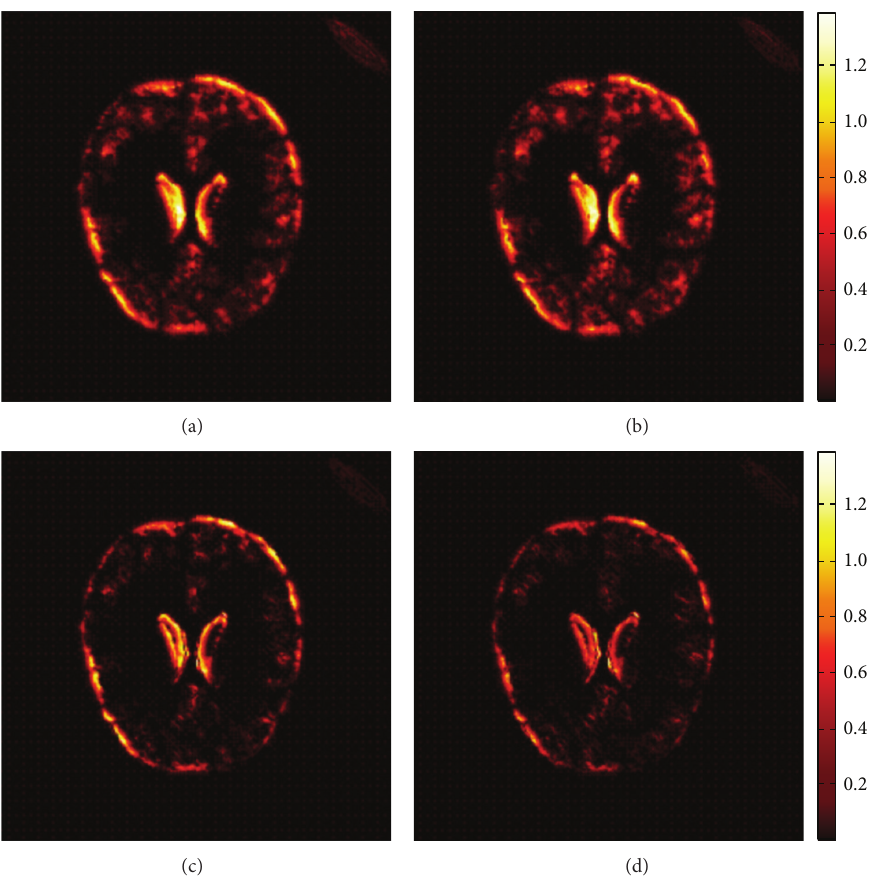
Figure 4: The differences of the known deformation fields with those got by various methods. (a) The difference of known deformation field with that obtained by the FMSF. (b) The difference of known deformation field with that obtained by the FMAF. (c) The difference of known deformation field with that obtained by the MMSF. (d) The difference of known deformation field with that obtained by the MMSF.